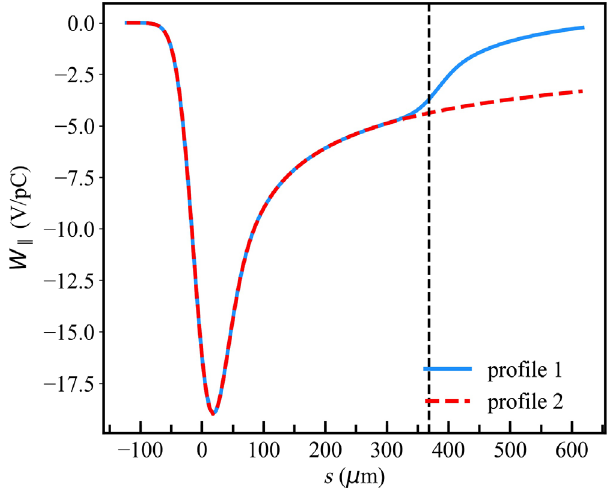
FIG. 4. Wake potentials due to a bunch with σ ¼ 25 μ m for the cavities with profile 1 (solid blue) and 2 (dashed red). The black dashed line indicates the value of λ profile